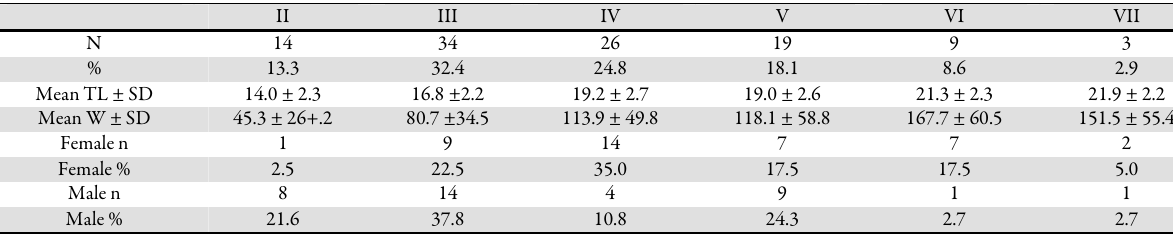
Table 3. Sex ratio, total length (cm) and weight (g) for different ages of C.